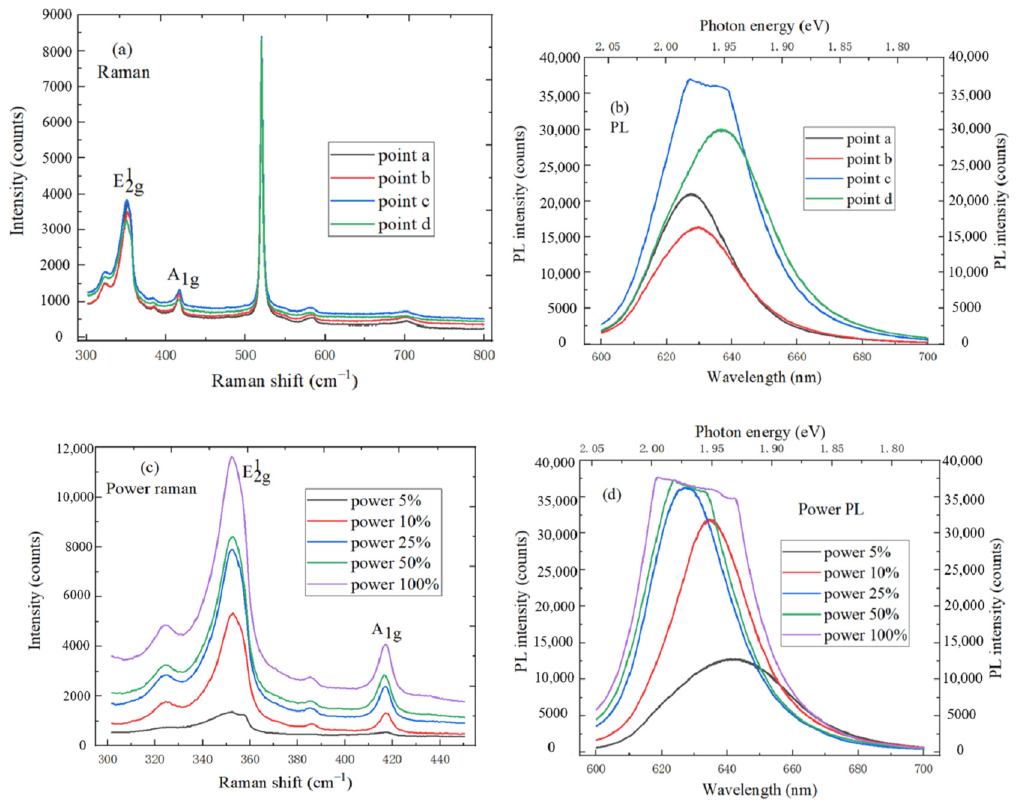
Table 1. A 1g peak and E 12g peak positions of different WS 2 layers.